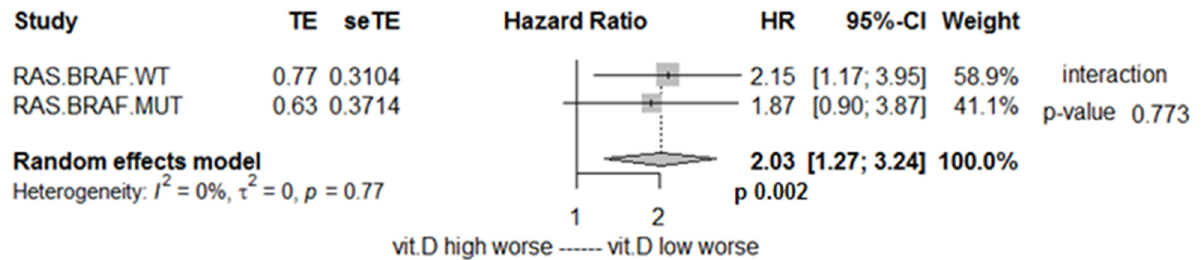
Figure 3. Impact of vitamin D on overall survival according to RAS and BRAF mutational status presented as meta-analysis. RAS.BRAF.WT: patients with RAS and BRAF wild-type. presented as meta-analysis. RAS.BRAF.WT: patients with RAS and BRAF wild-type. RAS.BRAF.MUT.: RAS.BRAF.MUT.: patients with either RAS or BRAF mutation; vit.D: Vitamin D. patients with either RAS or BRAF mutation; vit.D: Vitamin